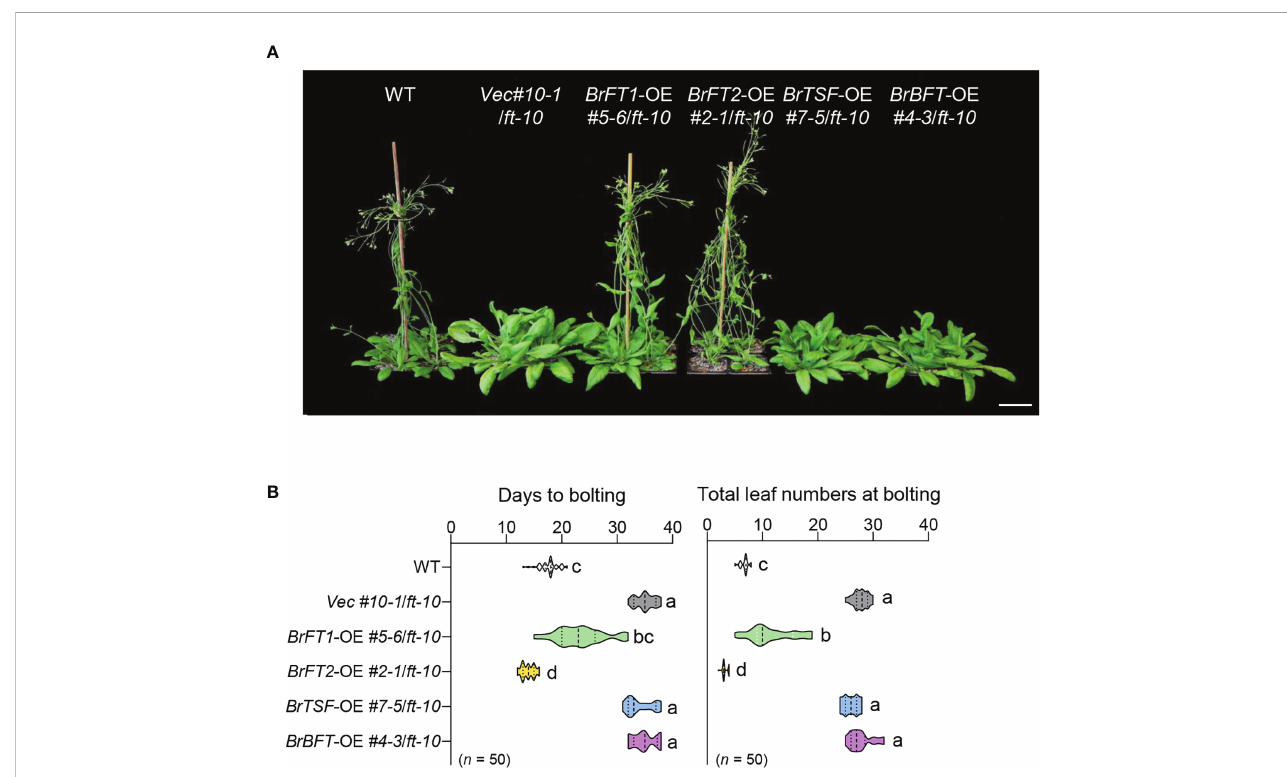
FIGURE 2 Ectopic expression of BrFT1 and BrFT2 causes fl owering in the Arabidopsis ft-10 mutant. (A) The ectopic expression lines BrFT1-OE #5-6/ ft-10 , BrFT2- OE #2-1/ ft-10 , BrTSF-OE #7-5/ ft-10 , or BrBFT-OE #4-3/ ft-10 and the empty vector control ( Vec #10-1/ ft-10 ) were compared with the wild type (WT, ecotype Col-0). Plants were grown at 23°C under LD conditions for 30 days. Scale bar, 5 cm. (B) Distribution of fl owering phenotypes (as days to bolting [left] and number of rosette leaves [right]) in T 3 lines, shown as violin plots. Five biological replicates were performed for analysis ( n of each replicate ≥ 10). Different lowercase letters represent signi fi cant differences, as determined by one-way ANOVA followed by Tukey ’ s post-hoc test ( P <